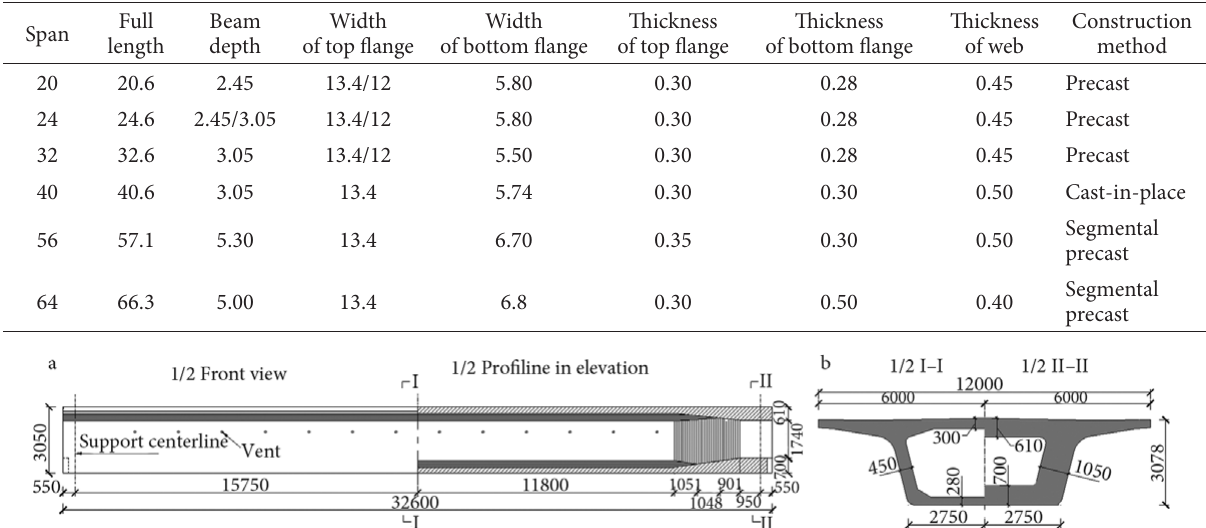
Table 1. Detailed dimensions of HSR simple beams, in m Span